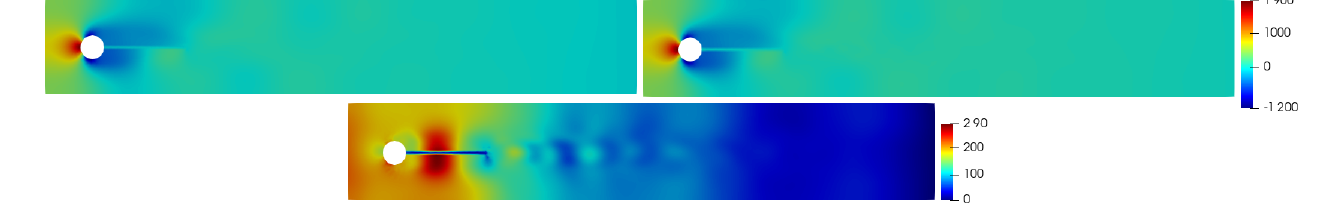
Figure 9. Fluid pressure at time t = 0.9 s: the FE solution ( top left ) and the reduced order solution ( top right ). Bottom: approximation error | p f , h − p f , N | . N p = 21 basis functions were used for the fluid pressure, with the supremizer enrichment technique.